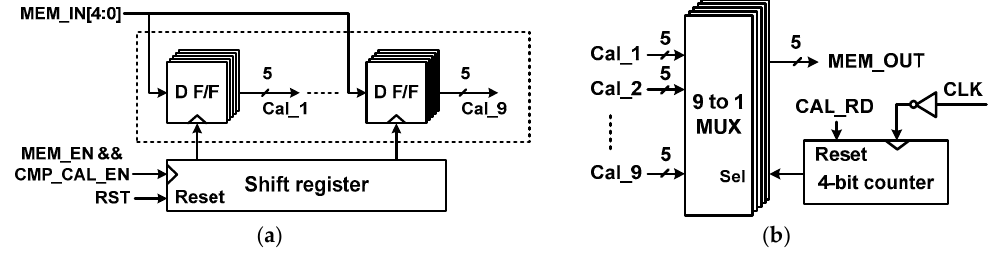
Figure 6. Block diagram of the register control for the ( a ) data write and ( b ) data read operations.